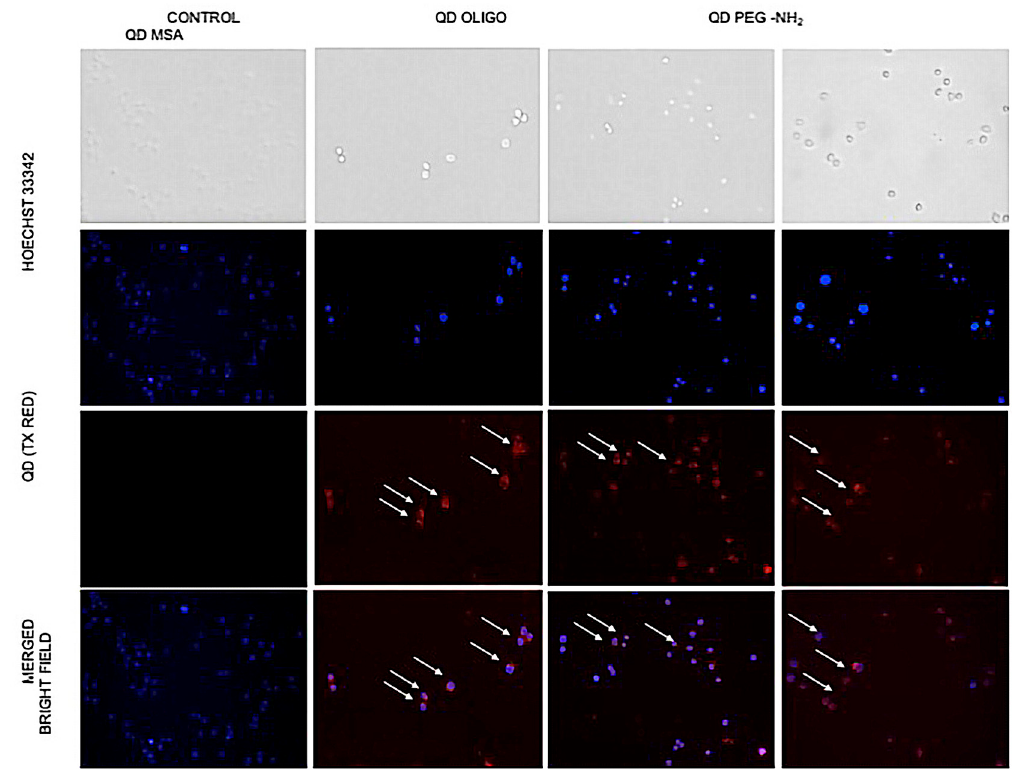
Figure 7. Fluorescence microscopy of RAW 264.7 cells exposed to QDs Oligo, QD PEG-NH 2 and QD MSA after 2 h treatment. The cell nucleus was stained with HOECHST 33342 (blue). The signals from QDs are shown in red. The arrows show co-localization of nucleus and QDs. Scale bar: 20 μ m.